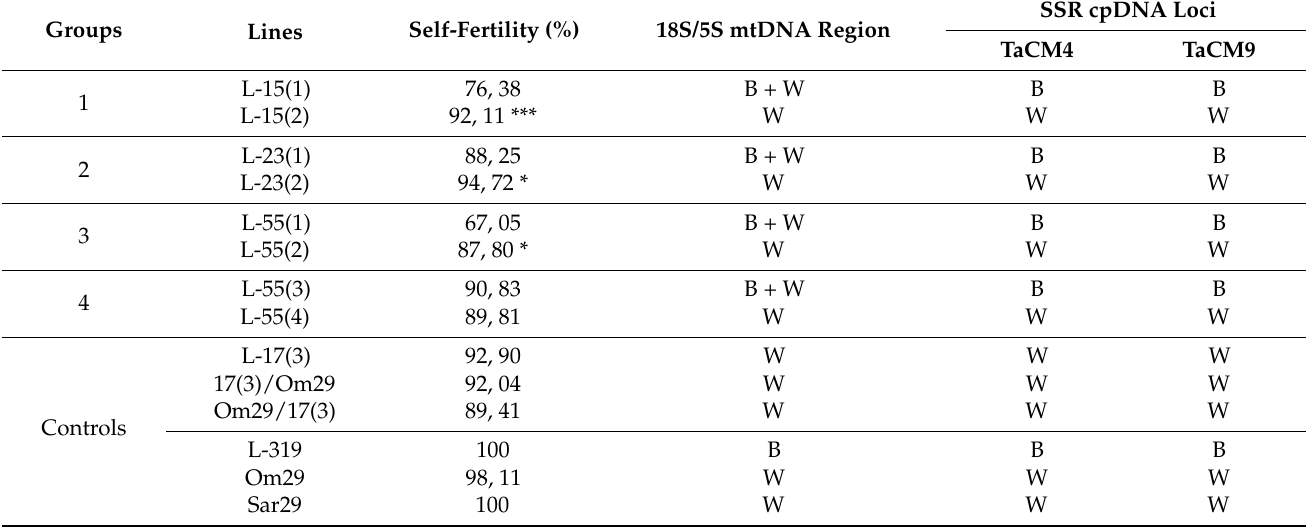
Table 3. Results of the study of fertility and mt and cpDNA regions in alloplasmic recombinant lines ( H. vulgare )- T. aestivum . (B: barley; W: wheat; the difference compared with the other line of its group is significantly higher when * p < 0.05; *** p < 0.001, Student’s t